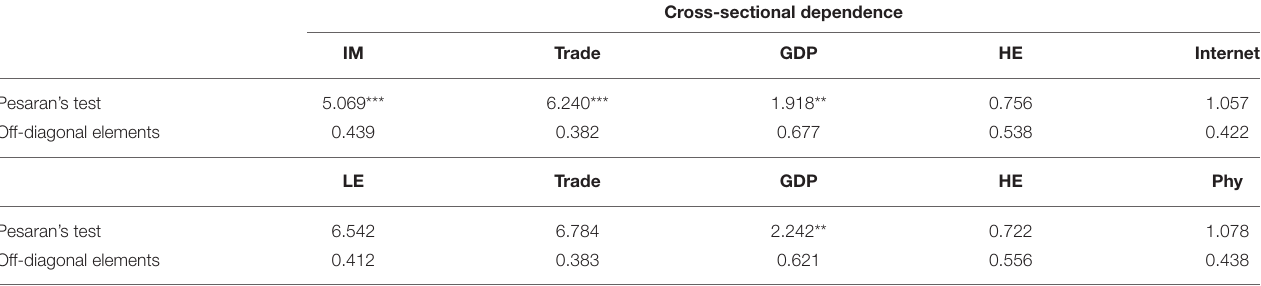
TABLE 2 | Cross-sectional dependence and cointegration